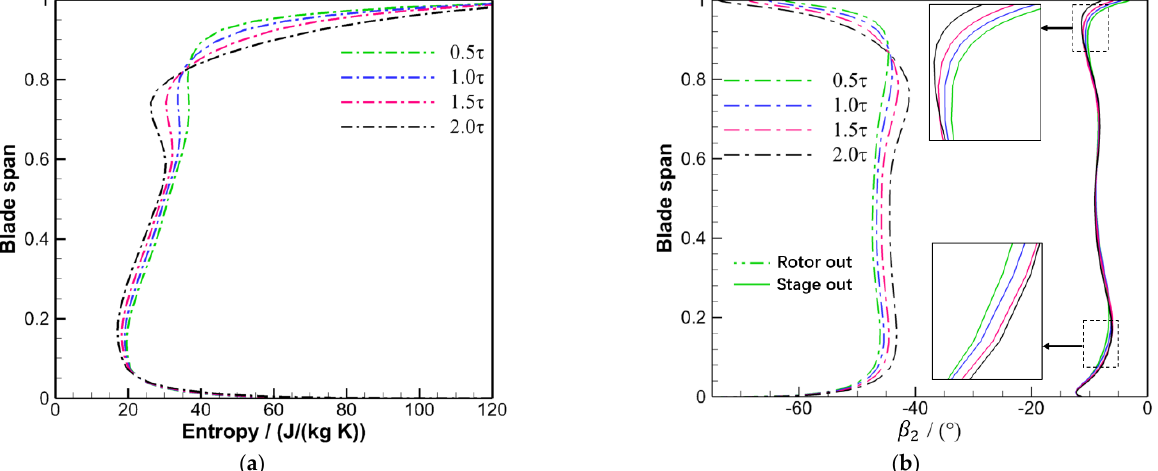
Figure 15. Spanwise distribution of pitch-averaged entropy and flow angle at the rotor outlet and stage outlet at P1: ( a ) Entropy ; ( b ) Flow angle . ( a ) Entropy; ( b ) Flow